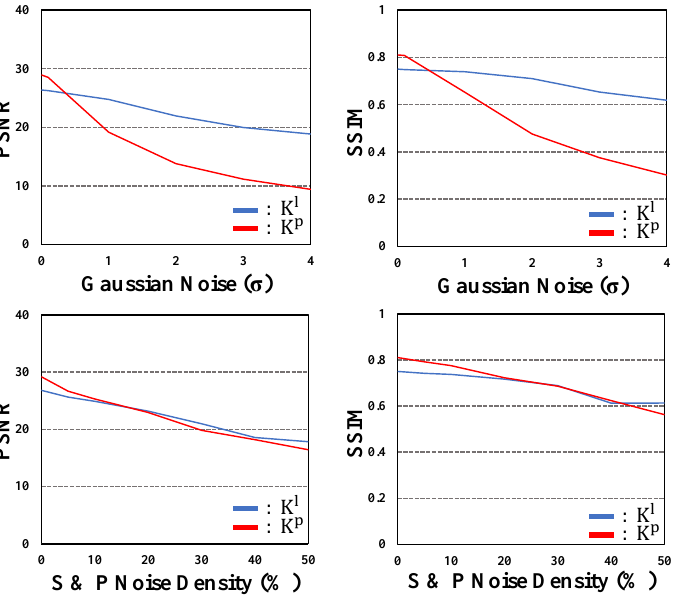
Figure 5. Average PSNR and SSIM measures on secret images reconstructed from private keys contaminated by various noises. (Red: K p , Blue: K l